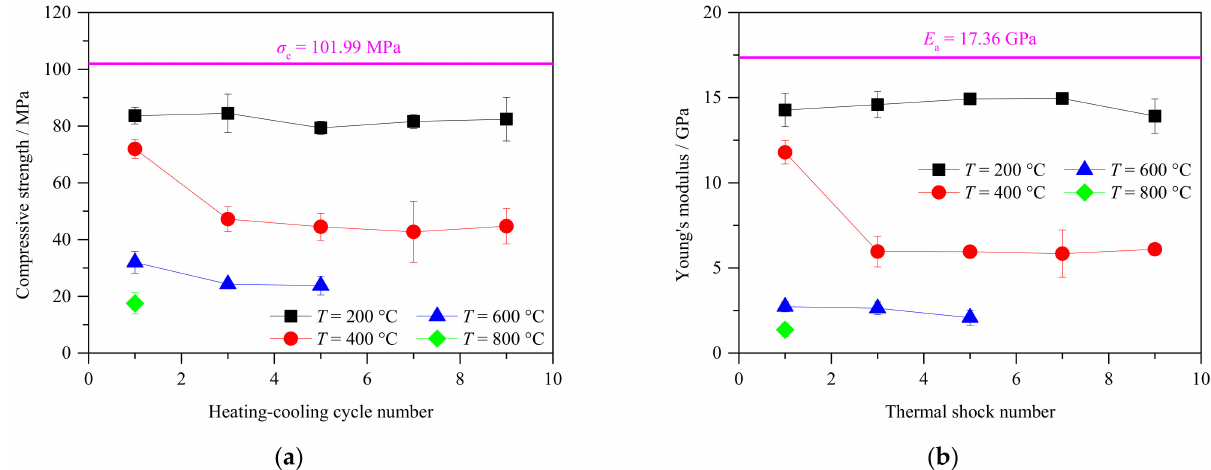
Figure 5. Influence of thermal shock numbers on the ( a ) compressive strength and ( b ) Young’s modulus (The error bar represents the standard deviation).